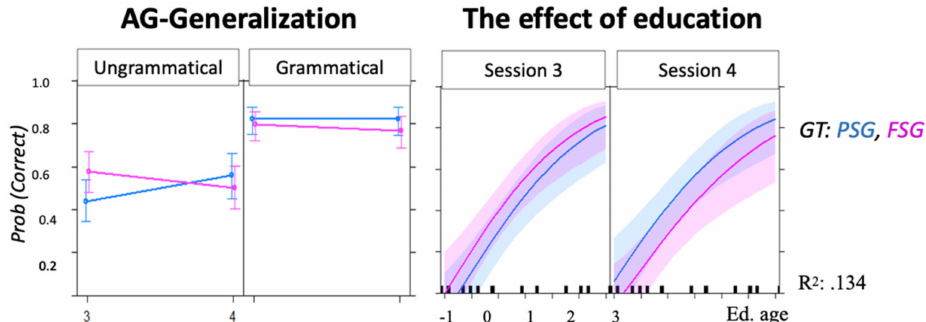
Figure 6. Syntax generalization (25 LHSP): AG generalization effect was significant only for the embedded grammar (in blue). This effect was mainly driven by the ungrammatical items. Educational age (ed. Age) positively influenced generalization of both GT in each session. The effect of grammar type remained significant. Table 5. AGG results in LHSP. Fixed effects and their interactions were listed. A. Generalization (S4, S3) R 2 = 0.0118, RI =